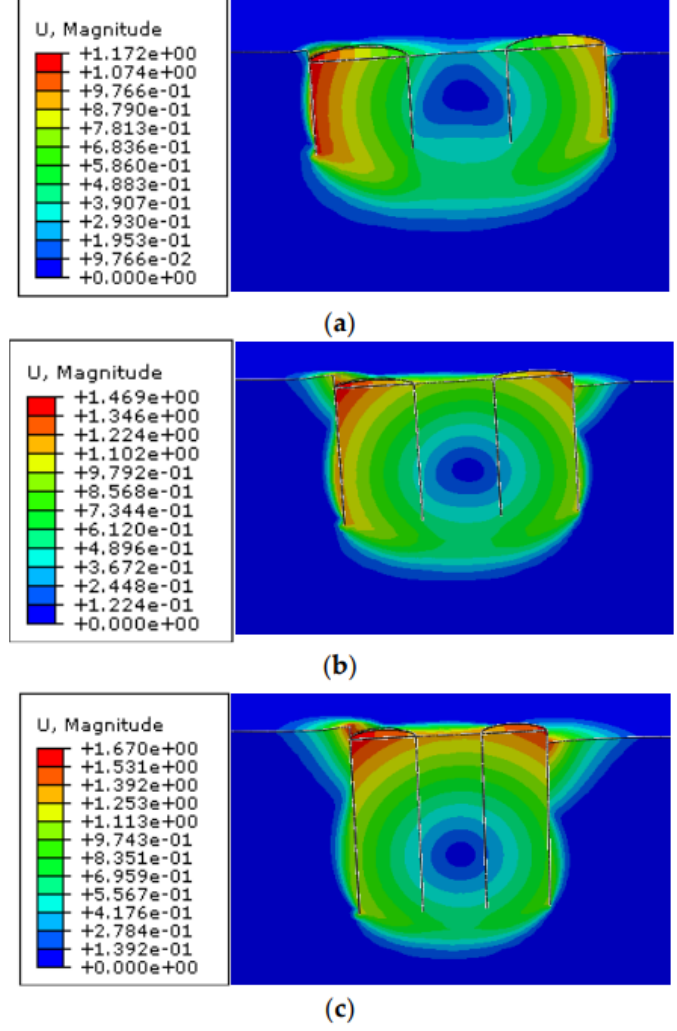
Figure 11. Displacement contours under moment loading ( S / D = 1): ( a ) L / D = 1; ( b ) L / D = 2; ( c ) L / D = 3.